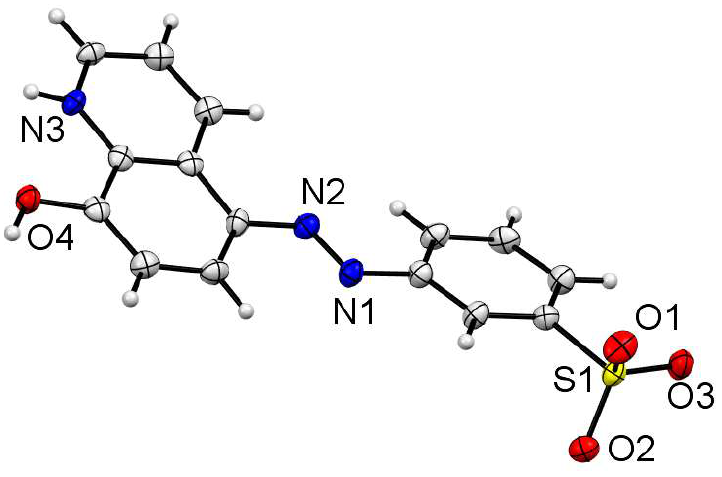
Figure 3. Contents of the asymmetric unit of free acid species H9 .H 2 O. The anhydrous and dihydrate forms have been previously reported and have similar zwitterion geometries [29,30].